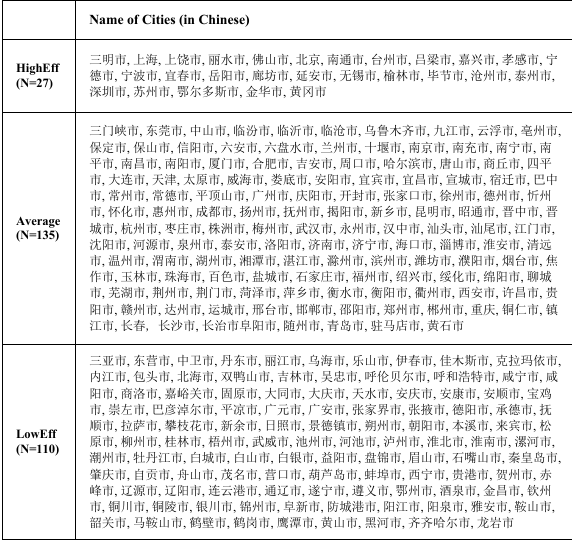
Table A. Latent class analysis results of Model 1.